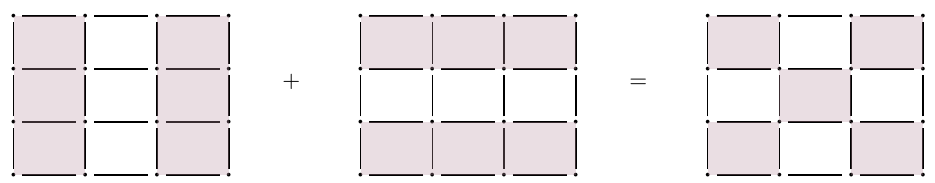
Figure 5 . Trivialization of ζ for a two-dimensional torus: ζ is the boundary of the sum of shaded faces, which are arranged in a pattern resembling a chessboard. Up to switching the roles of white and grey squares this is the only possibility in the two-dimensional case.